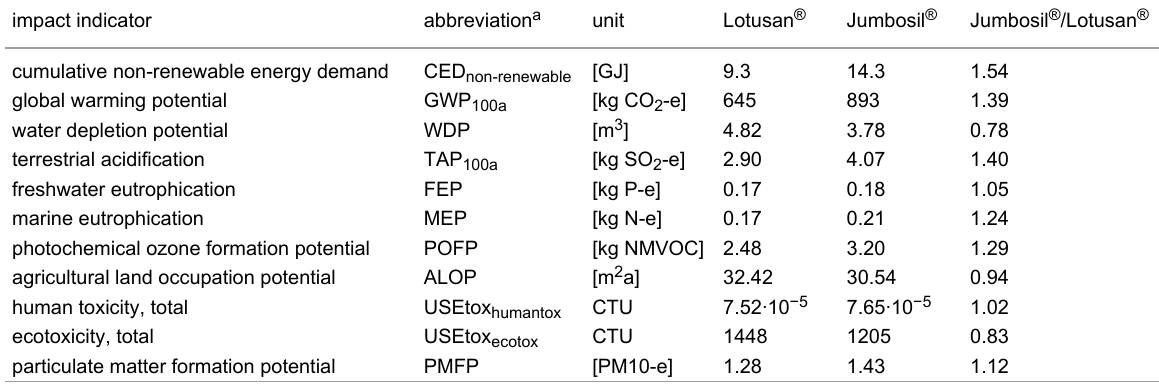
Table 2: Overall results of the life-cycle impact assessment shown for each impact